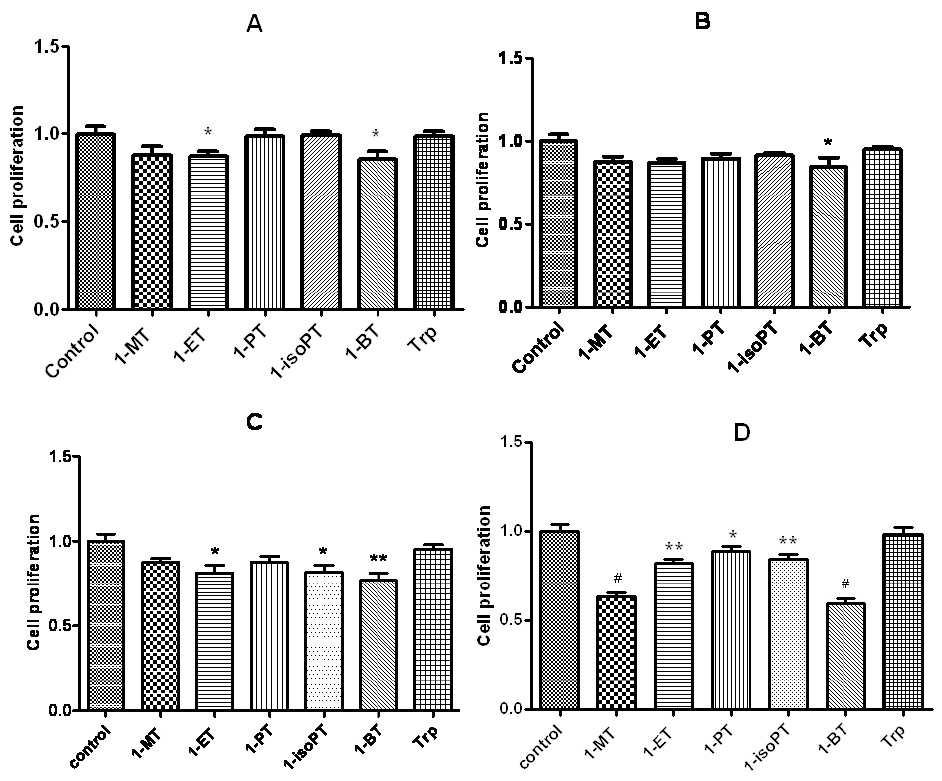
Figure 1. The effects of various concentrations of target compounds on SGC7901 cell proliferation. Cells were treated with various concentrations of the compounds (A) 0.1 mmol/L (B) 0.5 mmol/L (C) 1 mmol/L (D) 2 mmol/L for 48 hours and the relative cell viability was determined by MTT. The values are expressed as mean ± SD of three determinations.* p < 0.05, compared with Trp. ** p < 0.01, compared with Trp. # P < 0.01, compared with 1-ET.